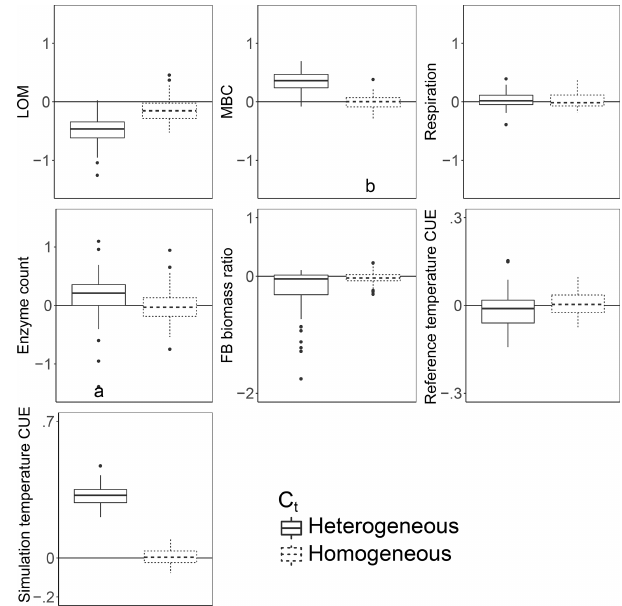
Figure 3. Effect of warming 5 ◦ C on C stocks and flows in simu- lations, reported as the natural log of the ratio of values in heated compared to control conditions. The CUE temperature response ei- ther varied between taxa (heterogeneous) or took on the fixed cross- sample mean temperature response of zero. Values above the zero line indicate that warming increased the value, and values below in- dicate a decrease with warming. Boxplots denote the first to third quartiles with the median. Asterisks denote a significant warm- ing effect based on a paired Wilcoxon test at Bonferroni-corrected P < 0 . 0001. Letters denote warmed scenarios which are signifi- cantly different from one another using the same criteria. “Refer- ence temperature CUE” denotes the ratio of CUE for the surviving community at 15 ◦ C in the warmed scenarios to the ratio of CUE for the surviving community at 15 ◦ in the control scenarios, while “simulation temperature CUE” denotes the ratio of CUE in heated scenarios run at 20 ◦ C to control scenarios run at 15 ◦